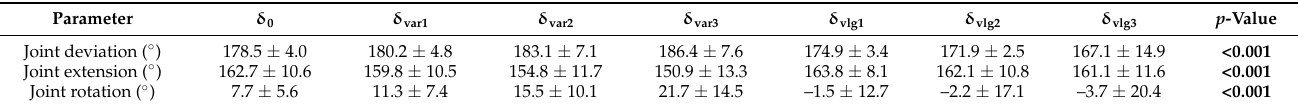
Table 6. Mean values of joint alignment, i.e., joint deviation (in the coronal plane), joint extension (in the sagittal plane), and joint rotation (in the axial plane) as a function of loading. Mean ± standard deviation ( ◦ ). Statistical analysis was performed using repeated measures ANOVA and statistically significant results are indicated in bold type